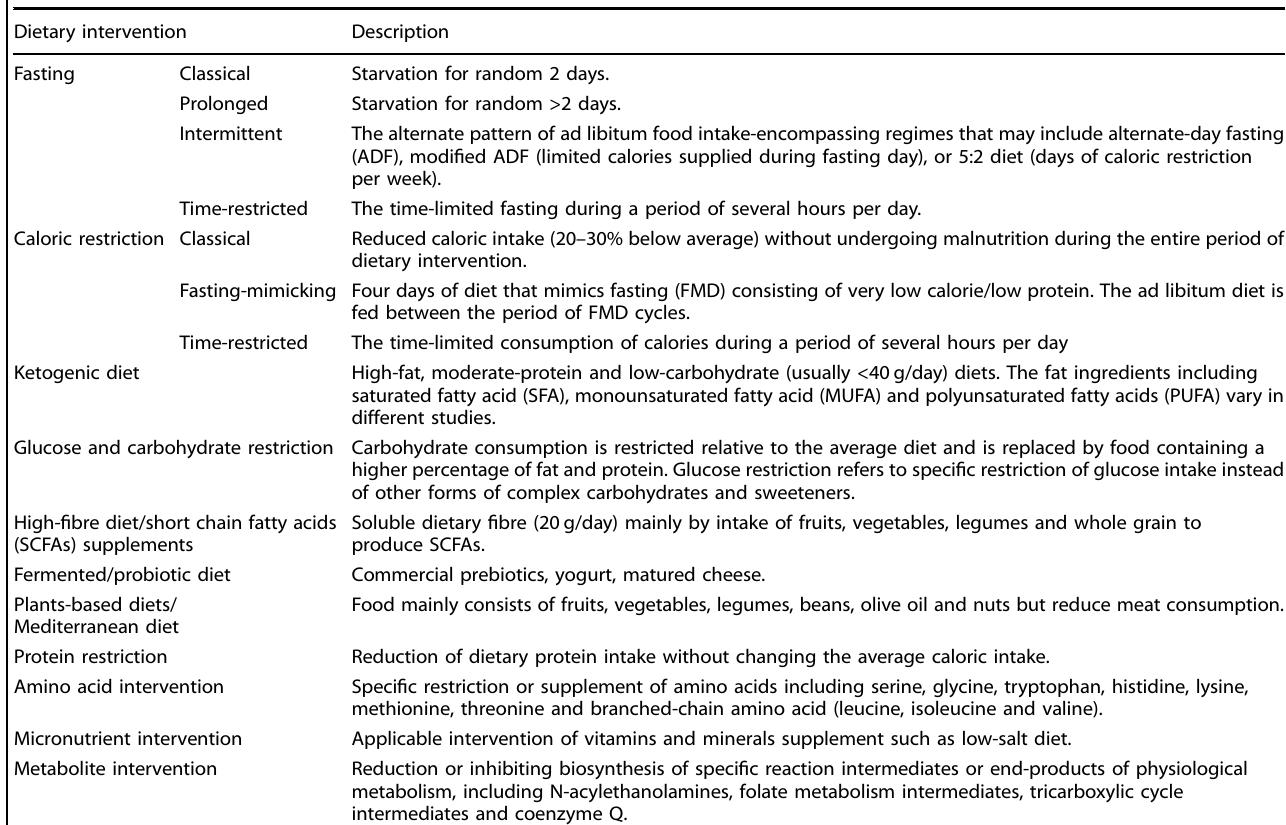
Table 1. Types of dietary